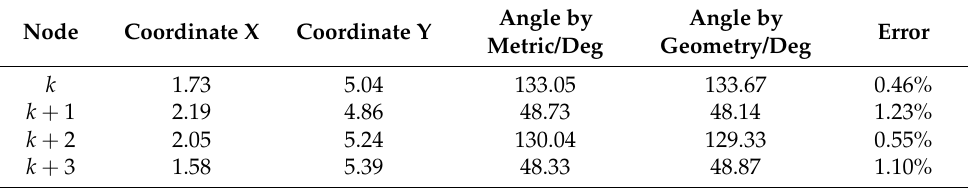
Table 3. Comparison between the mapping-based method and geometrical